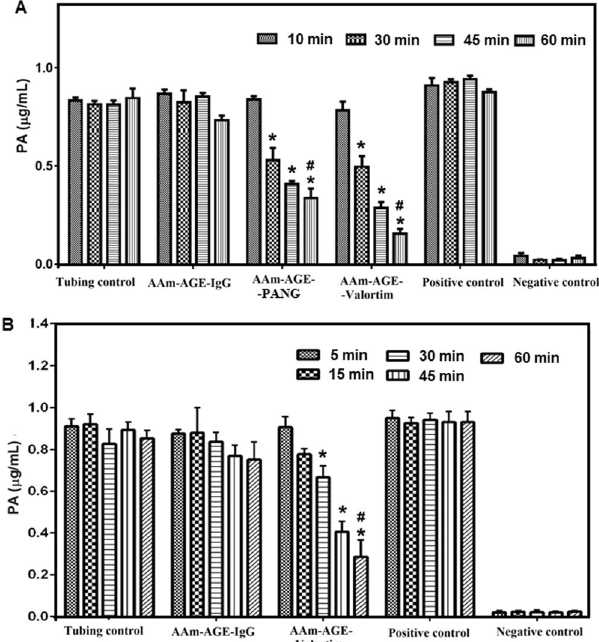
Figure 4. ( A ) Plasma and ( B ) whole blood PA concentration at indicated time points as determined by sandwich ELISA. Bar graphs shown are mean ± standard deviation (n = 3). Significant differences between cryogel groups were determined using a two-way ANOVA followed by Bonferroni’s post-hoc test to compare concentration of PA removed by cryogels. ‘ * ’Indicates significant different values within the same group (p < 0.05), while ‘#’values indicate statistically significant differences between the cryogel groups (p <